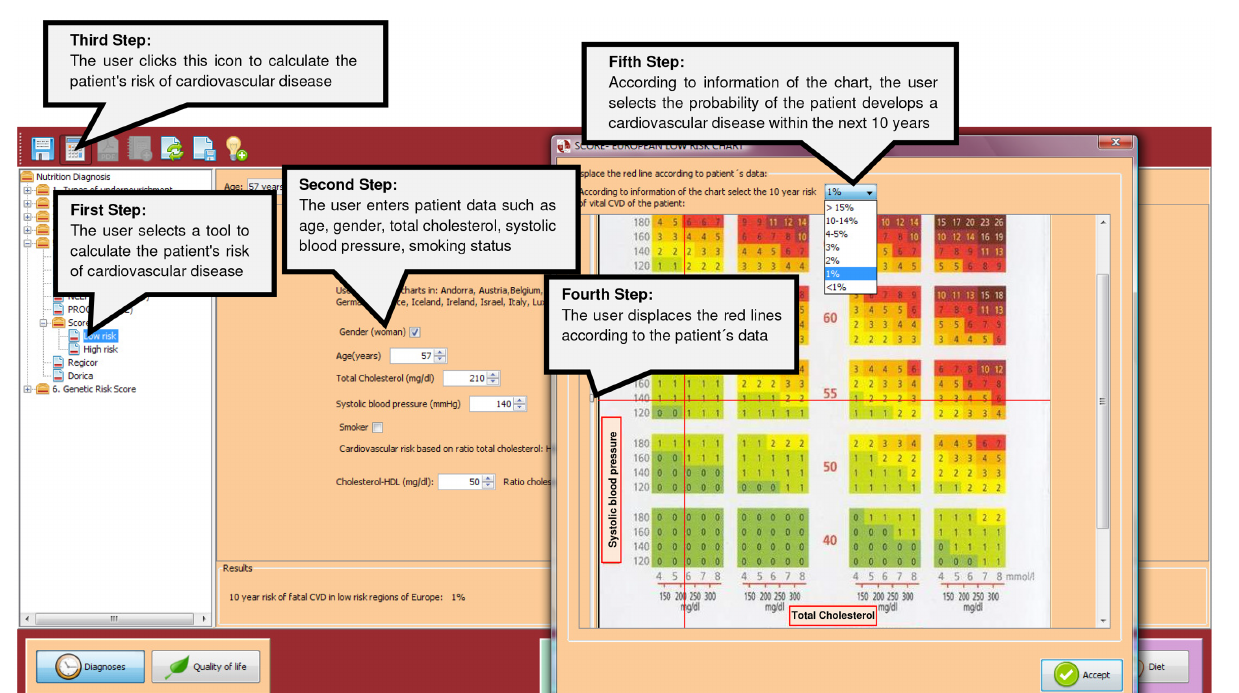
Fig 4. A screenshot of a risk chart of the Cardiovascular Risk